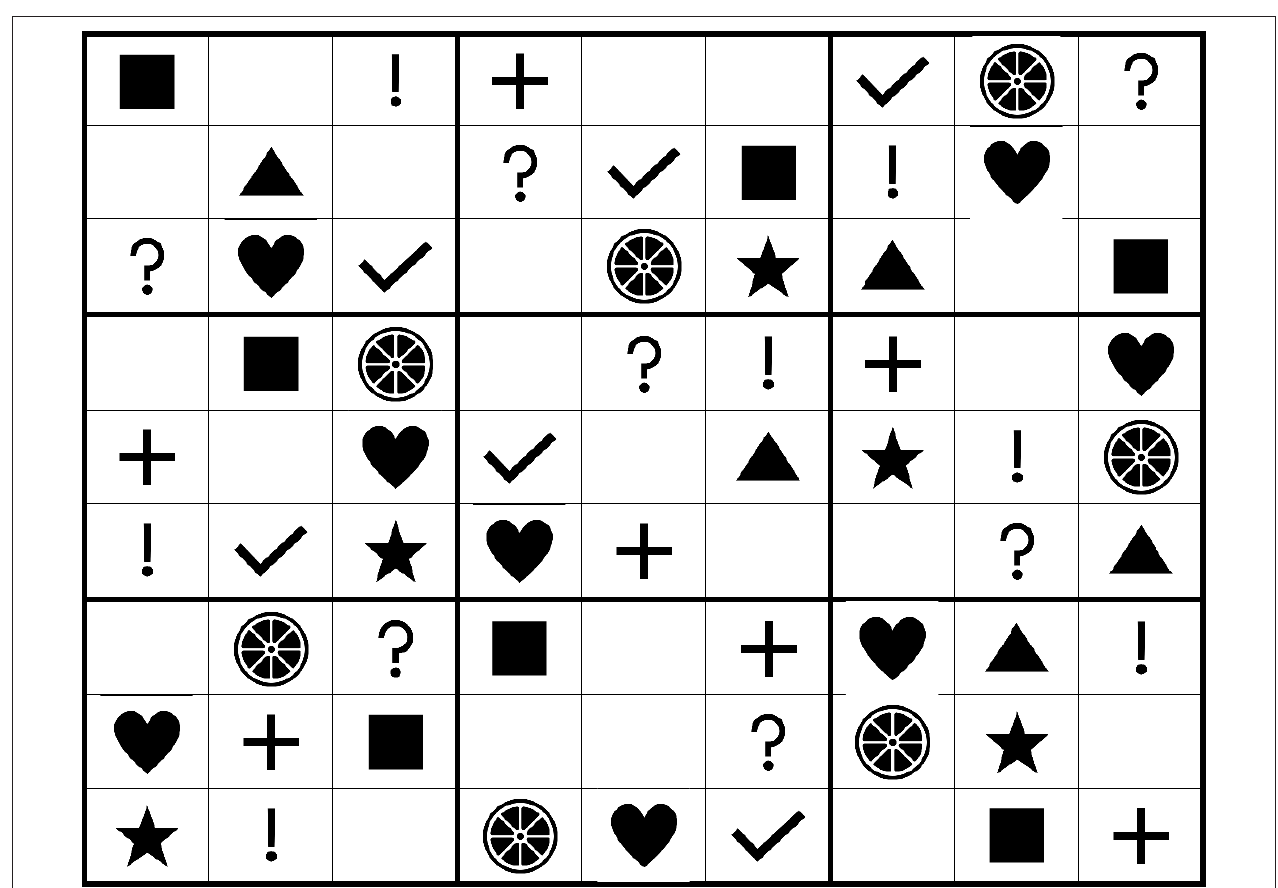
FIGURE 3 | Genie-ous (shape sudoku)